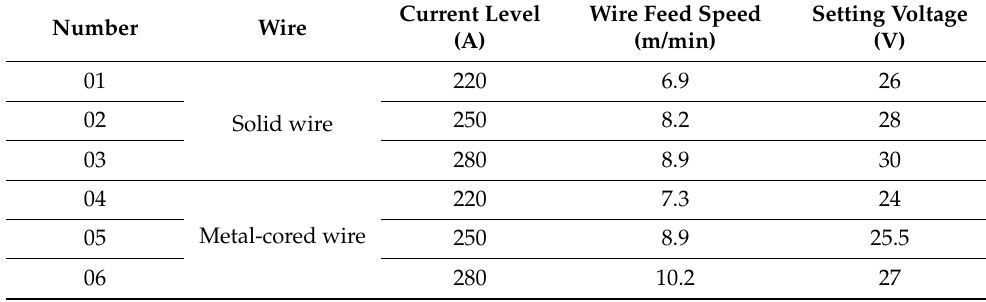
Table 2. Welding